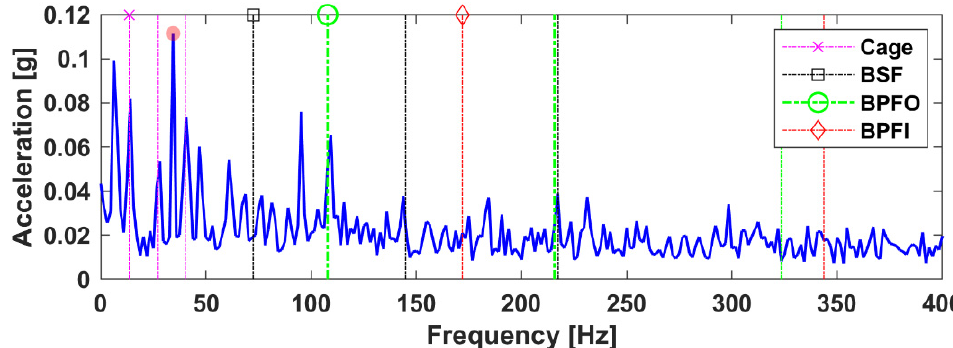
Figure 16. Smoothed envelope spectrum (with 90% overlap and resolution at 1.5625 Hz).